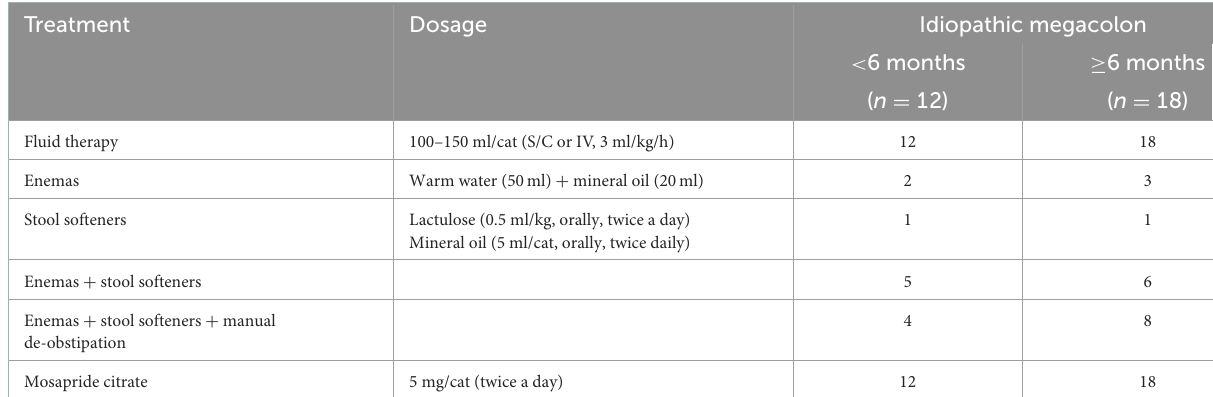
TABLE 4 Conservative treatment offered to the cat patients diagnosed with idiopathic megacolon and grouped into two subgroups based on the duration of clinical